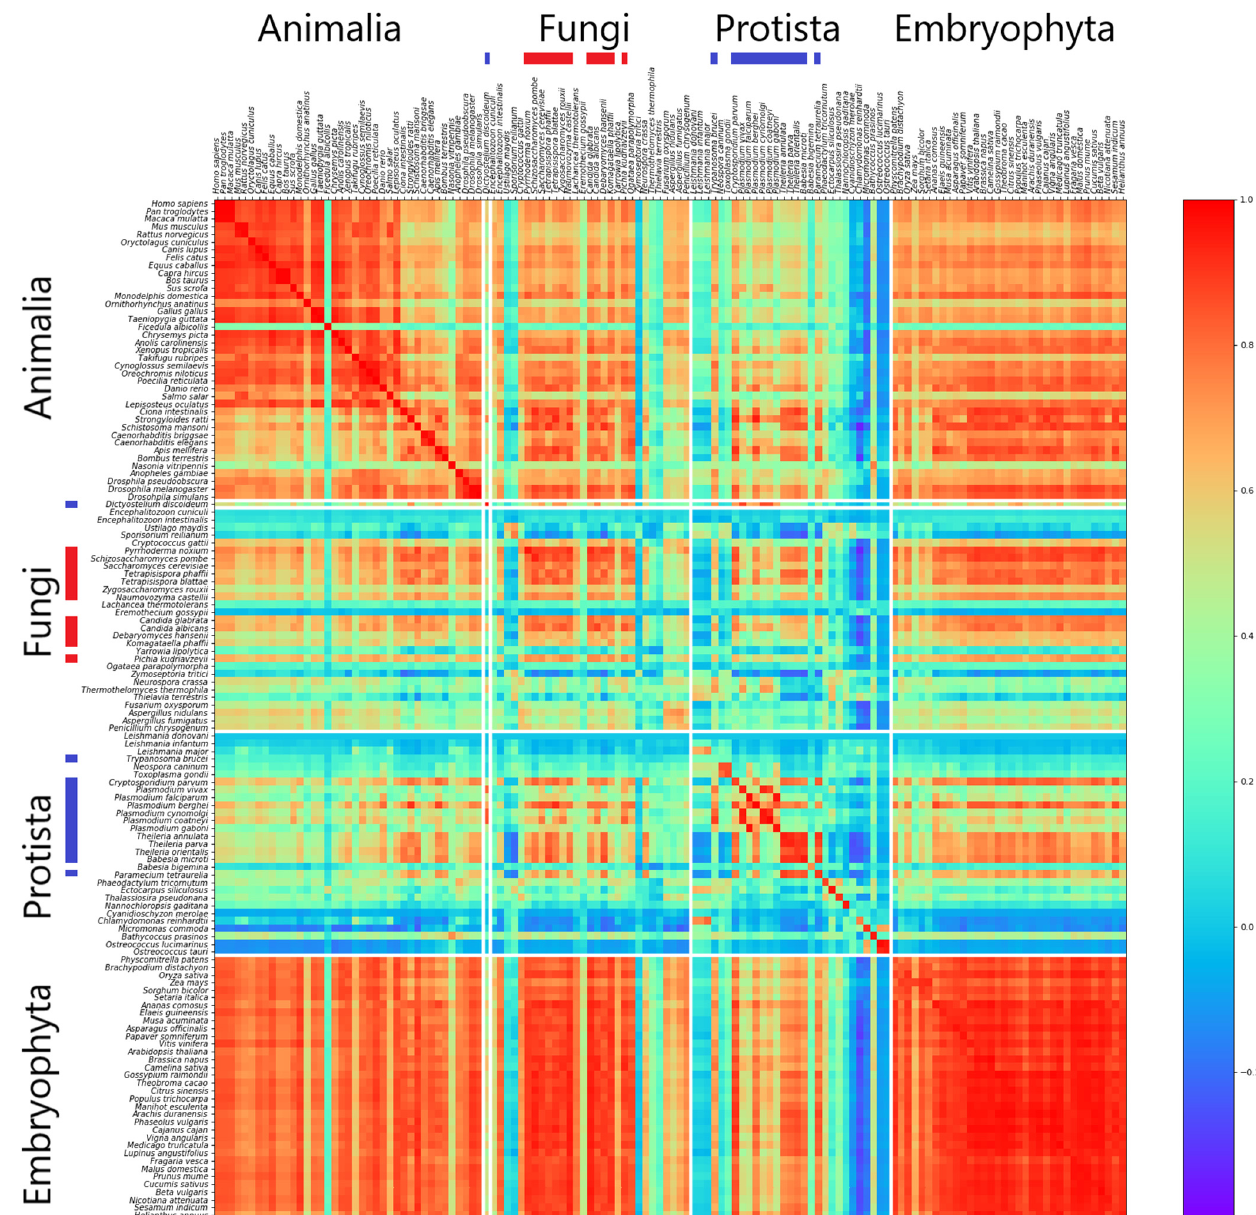
Figure 2. Heatmap of Correlations between individual intronic and intergenic regions ( Animalia , Fungi , Protista and Embryophyta , k = 7). Each row represents the pairwise correlation values (Pearson correlation) of introns for the listed organism, while every column is associated with the intergenic region of an organism. Color scale is limited in heatmap to values above − 0.4 for better readability. Genomes belonging to subset 1 in Protista are labelled with blue bars, and those of subset 1 in Fungi are labelled with red bars on the axes. The protist Dictyostelium discoideum of subset #S1 of Protista is placed between Fungi and Animalia , as this very organism is a member of the Amoebozoa and has close relations to both kingdoms.